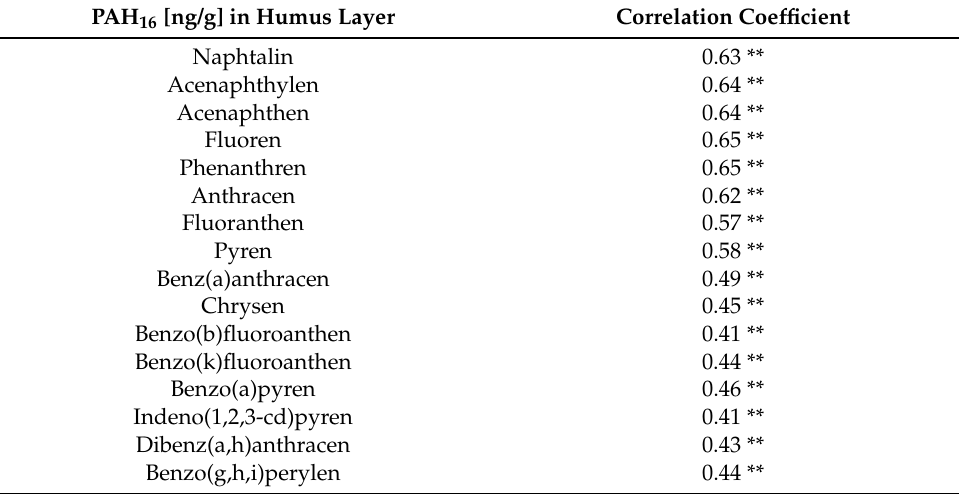
Table 11. Correlation coefficients between 16 PAH indicators in the humus layer and estimated Ca deposition at the NFSI plots for the reference year 1988 (kg/ha/a); significance: * p < 0.05, ** p <